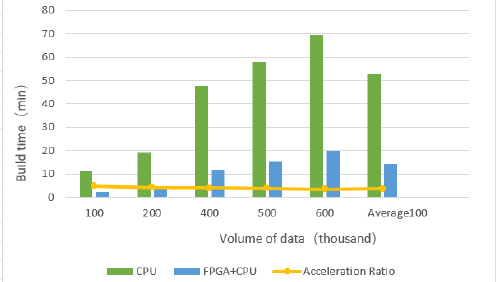
Fig. 5. Build time comparison results.